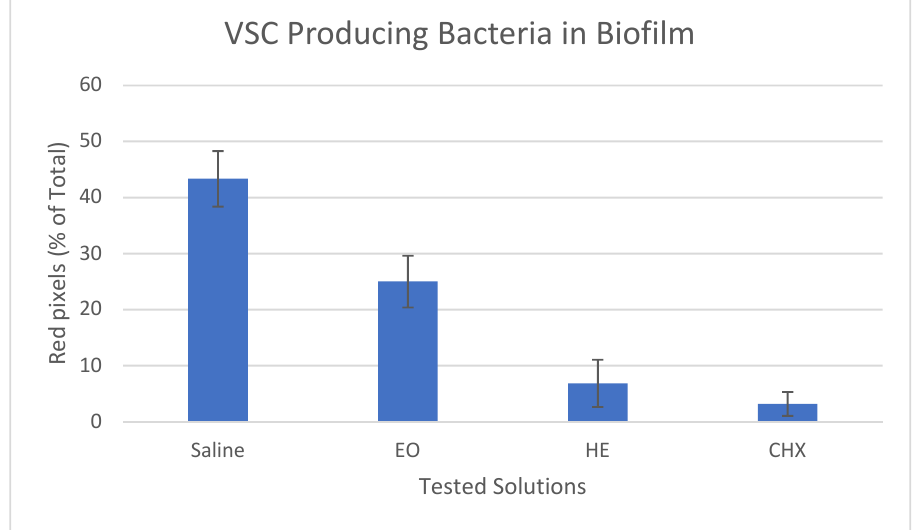
Figure 6. The mean results (±SD) of the quantification of VSC-producing bacteria within the biofilm formed on the PMMA discs measured using confocal microscopy for the various tested solutions: Saline, essential oils (EO), herbal extracts (HE), and chlorhexidine (CHX) formulations as indicated.